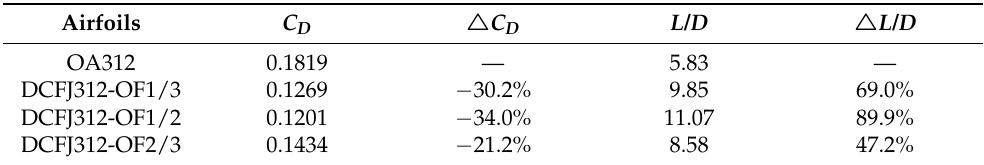
Table 9. Comparisons of drag coefficients and lift-to-drag ratios of DCFJ312 airfoils with various OF s at AoA = 20 ◦ .